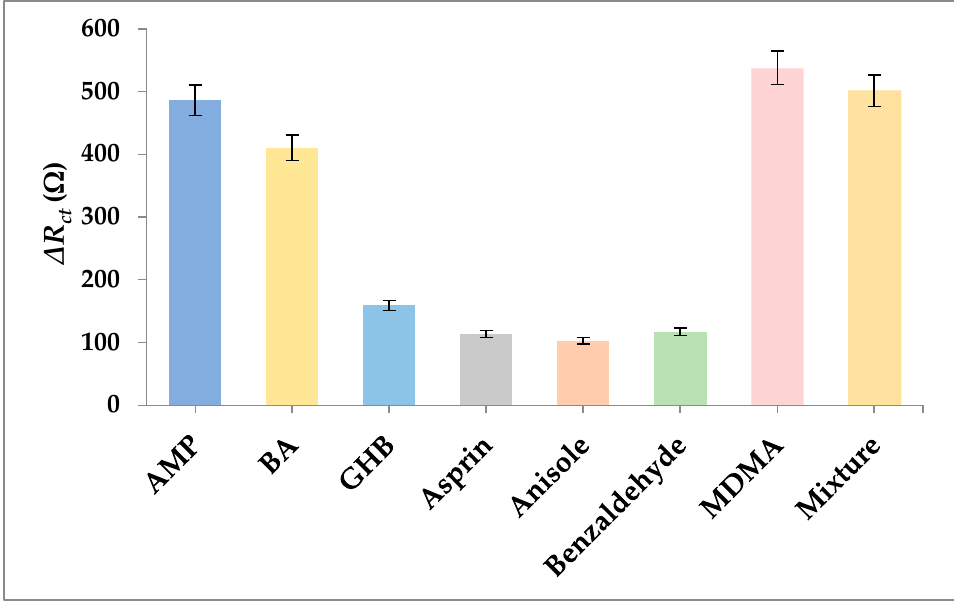
Figure 12. Selectivity analysis of aptasensor in the presence of 0.33 nM (±)-3,4-Methylenedioxymethamphetamine (MDMA), amphetamine (AMP), benzoic acid (BA), 4-Hydroxybutyric acid sodium (GHB), aspirin, anisole, benzaldehyde, and a mixture of the interferents.